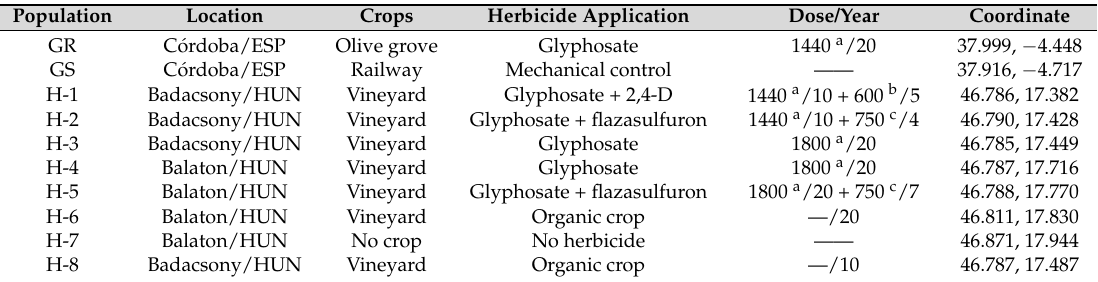
Table 1. Conyza canadensis populations harvested in different Hungarian (HUN) and Spanish (ESP)